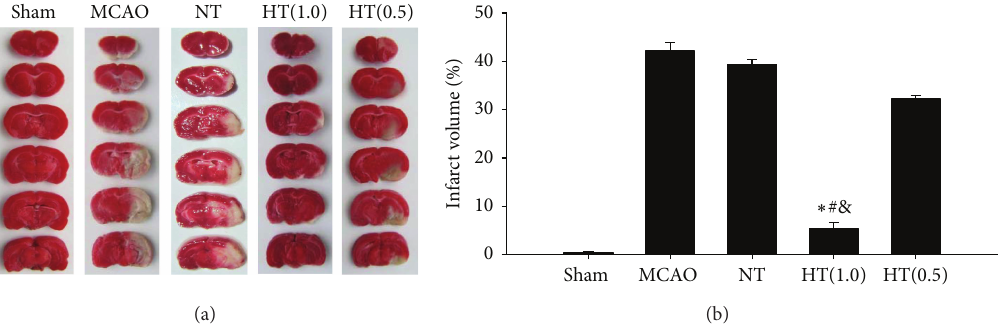
Figure 2: AIH reduces brain infarct volume in the ischemia/reperfusion rat model. TTC staining was used to measure the brain infarct volume 24h after reperfusion. (a) Representative infarct volume stained with TTC in each group. (b) Average infarct volume in rats treated with 5 󸀠 -AMP coupled with low Ta. All values are mean ± SEM. ∗ 𝑃 < 0.05 compared to the MCAO group, # 𝑃 < 0.05 compared to the NT group, and & 𝑃 < 0.05 compared to the HT(0.5) group.